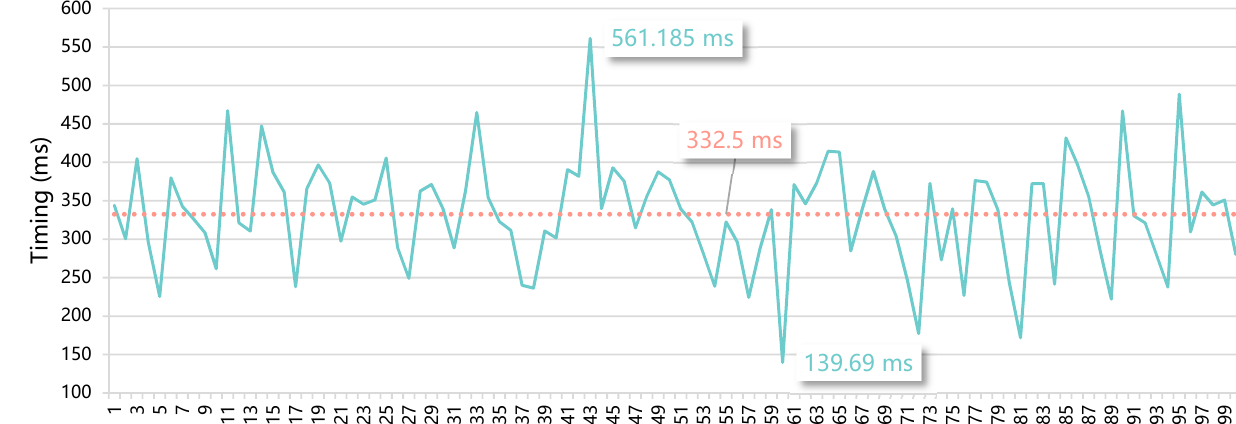
Figure 15. Results from Test 2, performed to measure the timings corresponding to how long a user takes to react after the detection of a marker and representation of the respective 3D model.